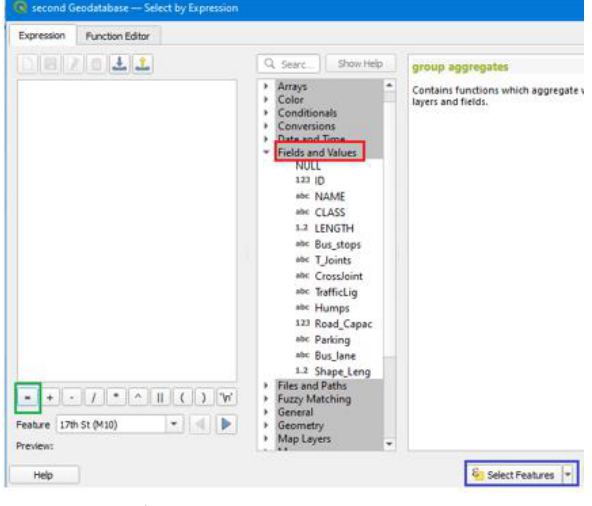
Figure 7 . Select by expression view.